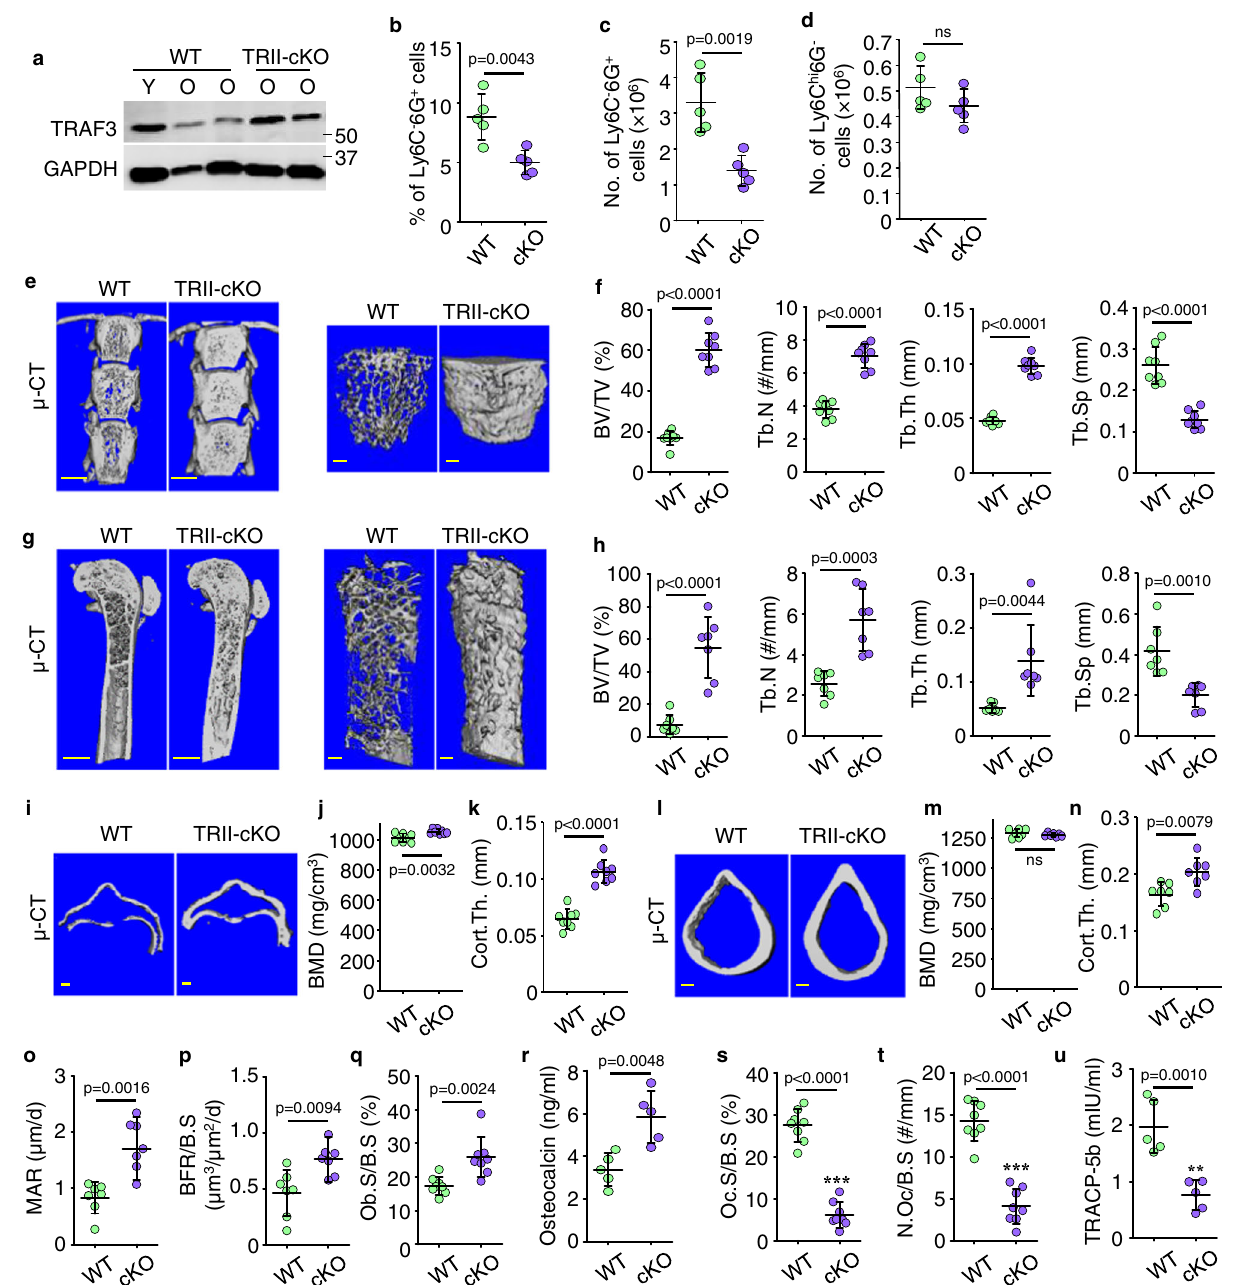
Fig. 8 | Mice with TGF β RII deleted speci fi cally in mesenchymal lineage cells havedecreasednumbersofTCNsinBMandincreasedbonemass.a WBofbone protein lysates from 3- (young) and 15-mon-old (old) TGF β RII fl / fl (WT) and 15-mon- oldTGF β RII fl / fl ;Prx1 Cre (TRII-cKO)mice. b , c Frequencies( b )andnumbers( c )ofLy6C - 6G + cells in TGF β 1 + CD11b + myeloid cells in BM from 15-mon-old WT and TRII-cKO mice. Mean±SD ( n =5 biologically independent male mice/group). d Ly6C hi 6G - cells in TGF β 1 + CD11b + myeloidcells in BMfrom 15-mon-old WT and TRII-cKO mice. Mean±SD ( n =5 biologically independent male mice/group). e Representative imagesofcoronalsectionsofT12-L2vertebraeand3Dreconstructionoftrabecular bone in L1 from T β RII-cKO and WT mice. Bar=1mm. f Trabecular bone volume, number, thickness, and separation in L1 from WT and TRII-cKO mice. Mean±SD ( n =3 female and 5 male biologically independent mice/group). g Sagittal sections and 3D reconstruction of trabecular bone in femora from TRII-cKO and WT mice. Bar=1mm. h Trabecular bone volume, number, thickness, and separation within thearea1mmbeneaththegrowthplateinWTandTRII-cKOmice.Mean±SD( n =3 female and 4 male biologically independent mice/group). i Horizontal cross